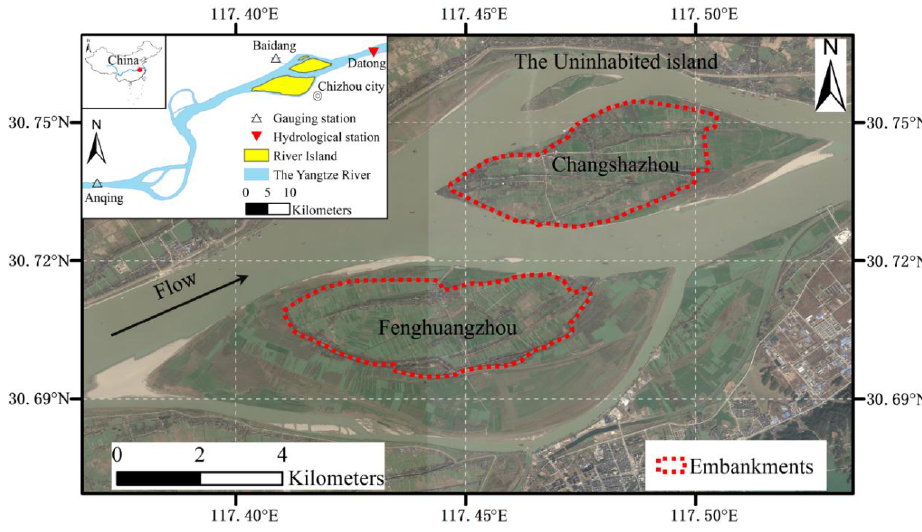
Figure 1. Map of the study site in the Yangtze River, showing the river islands Fenghuangzhou, Changshazhou and the u ninhabited island by Google Earth image acquired on January 21, 2017. At Anhui reach, the formation of the flood was mainly caused by channeling of the strong runoff (come from the upper and middle reaches of the Yangtze River), and the rainstorm flood (come from lakes, Chuanjiang River, and the Han River basin). The influence of the tributaries in the Anhui province is small, and the transit flood is the main source of flood. In Anhui province, the flood season of the Yangtze River is from May to October. The period from June to August is the high-water period. The highest water level in each hydrological station is mainly in this period; the dry season is from December to February. The lowest water level of each station over the years has mainly occurred in the dry season [39,40]. From the “2016 China Flood and Drought Disaster Bulletin” promulgated by